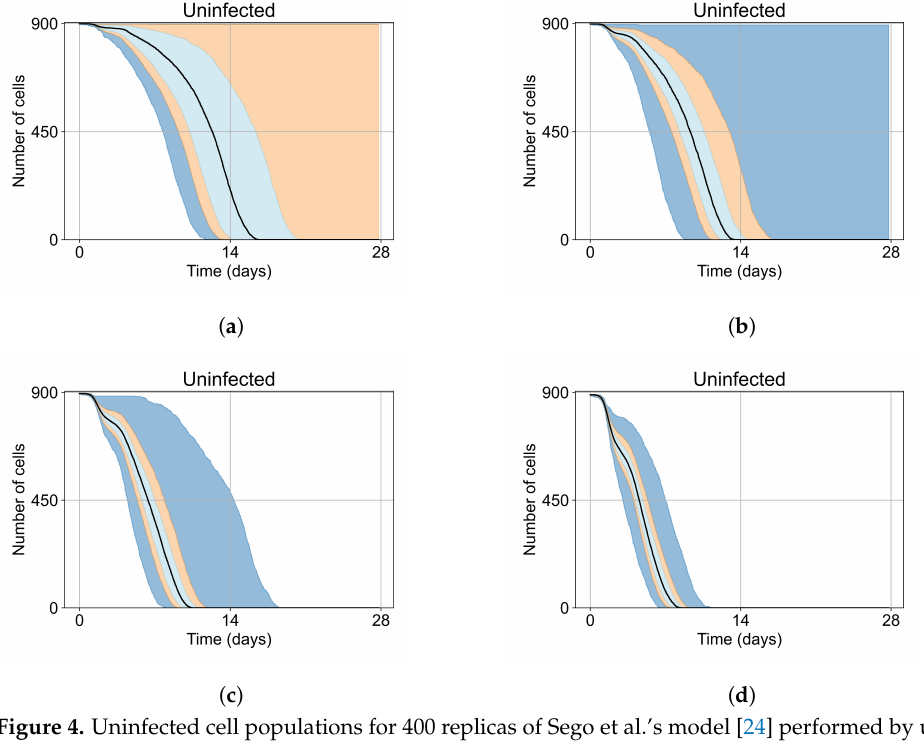
Figure 4. Uninfected cell populations for 400 replicas of Sego et al.’s model [24] performed by us are shown using Sego’s default parameters [24]. In all the cases, the medians of simulation replicas are in black lines, the 0th to 100th quantiles are shaded as dark blue, 10th to 90th shaded in orange, and the 25th to 75th as light blue. ( a ) Simulations start with 1 initially infected cell and 63 simulations result in “ failure to infect ” (15.75% of replicas), the 90th quantile includes the upper bound of the number of cells. ( b ) Simulations start with 2 initially infected cells where 5 simulations result in “ failure to infect ” (1.25%), and the 100th quantile includes the upper bound of the number of cells. ( c ) Simulations start with 5 initially infected cells. ( d ) Simulations start with 10 initially infected